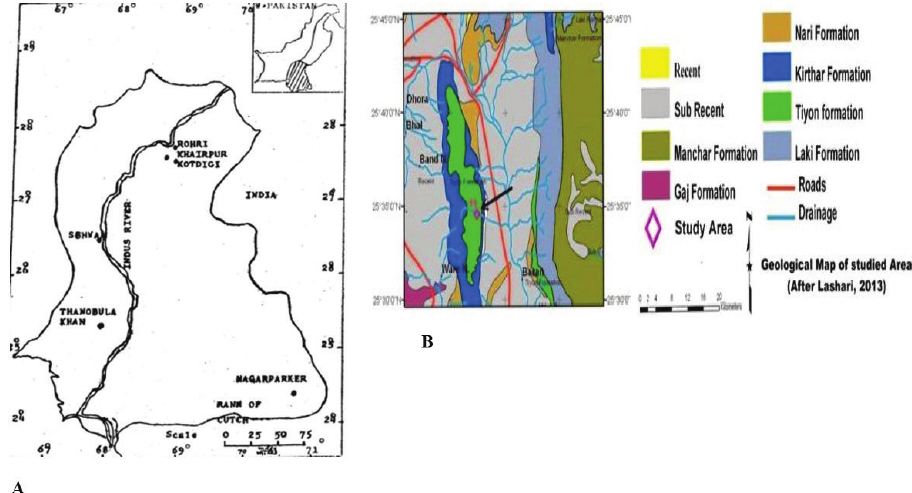
Figure1. A map of Sindh (Pakistan), showing the area of Thano Bula Khan from where the fossil wood was collected B geological map showing the Manchar Formation exposed in the study